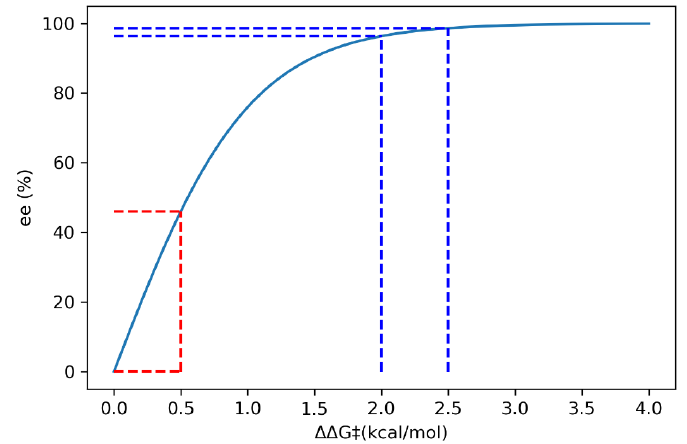
Figure 22. % ee vs. ΔΔG‡(kcal/mol) at 253K. Two intervals of 0.5 kcal/mol are included to illustrate the difference in calculated % ee .